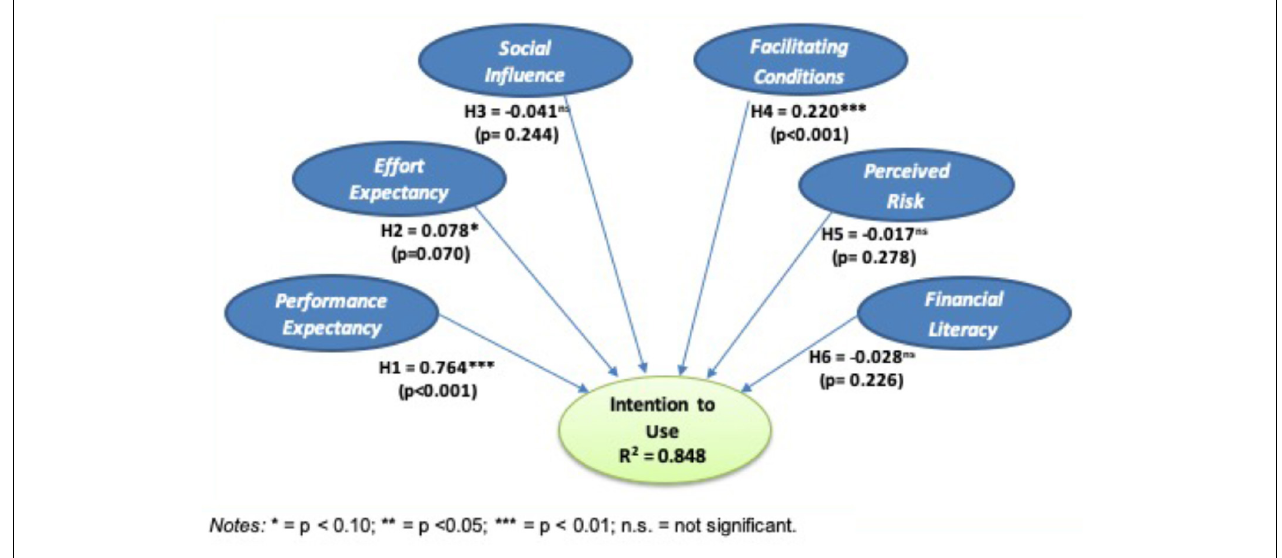
FIGURE 4 | Graphical model of the influence of the explanatory variables (path coefficients) on the intention to use cryptocurrencies and R 2 . TABLE 5 | Goodness of fit of the model, direct effects, p -value, correlation with the dependent variable and variance explained by the explanatory variables. R 2 Q 2 Direct effect p -value Correlation Variance explained